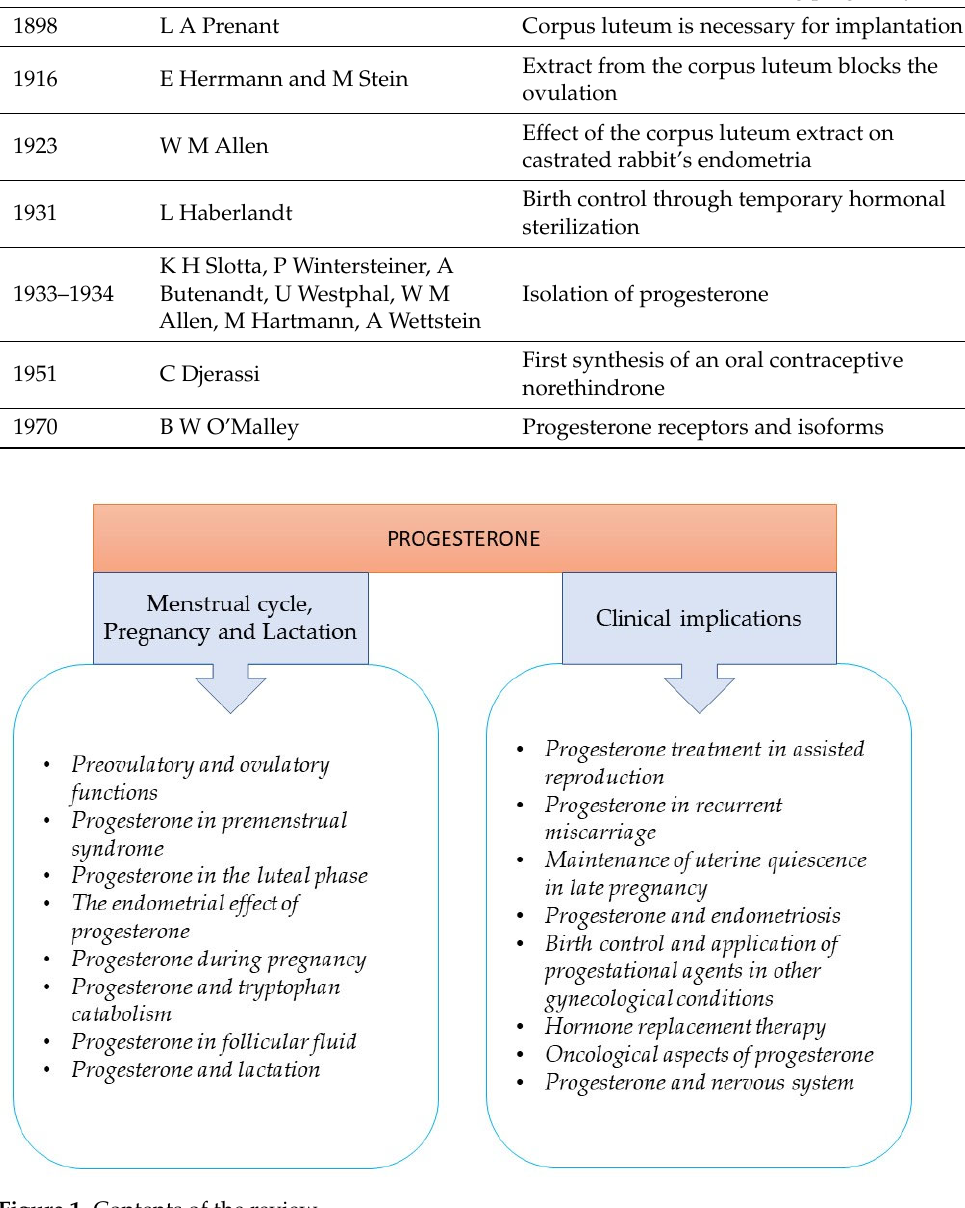
Figure 1. Contents of the